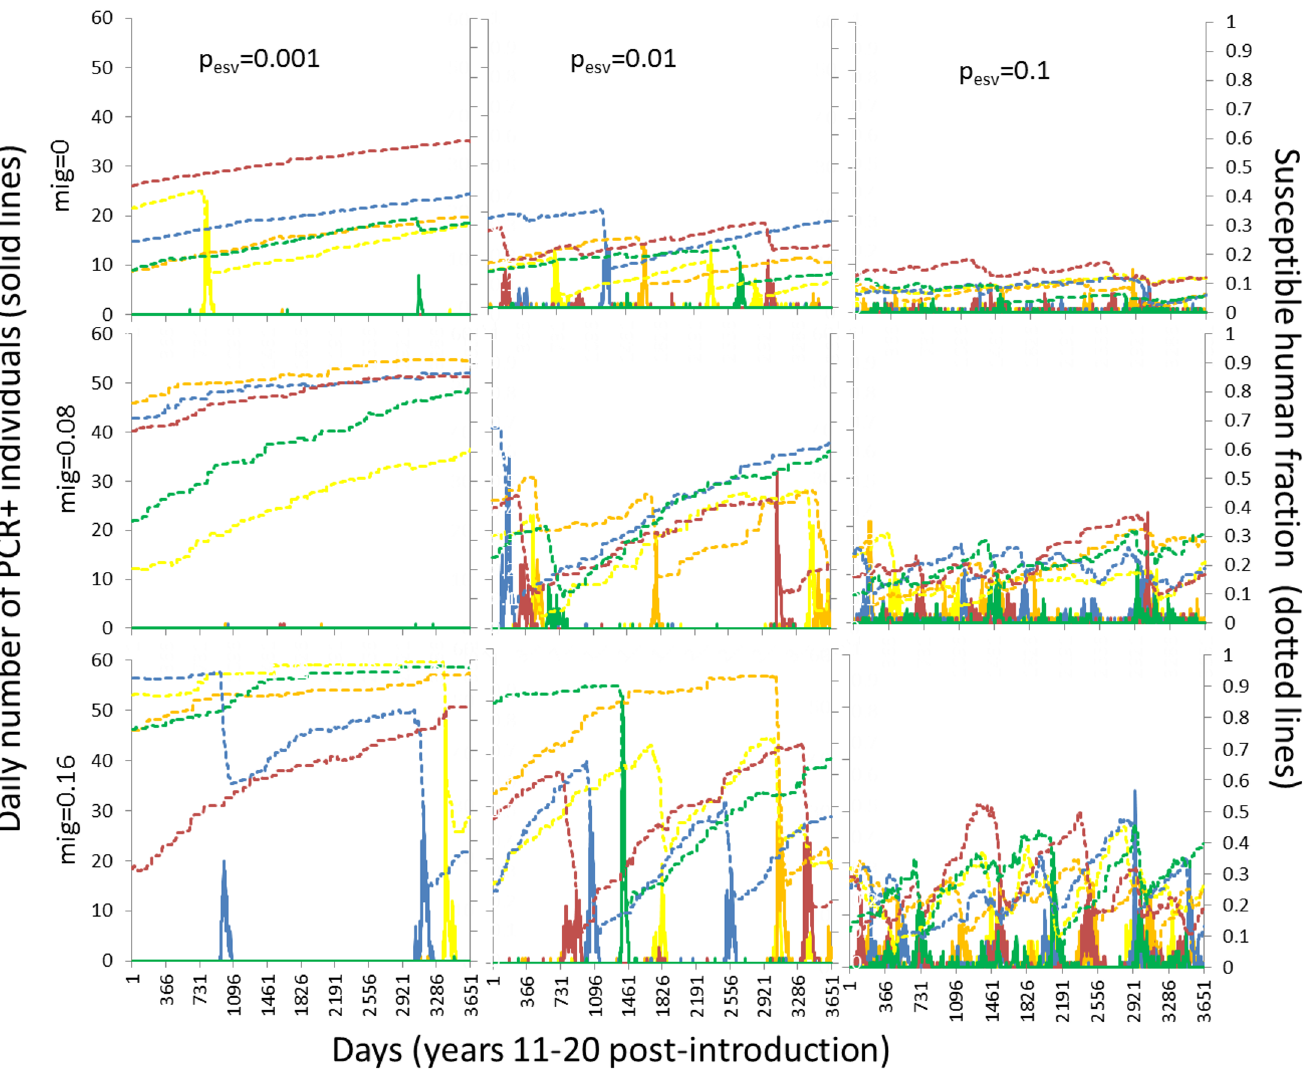
Fig 2. Daily dynamics of transmission 11 – 20 years post invasion for five randomly selected trials for each combination of external social vector exposure ( p esv ) (increasing from left to right) and migration ( mig ) (increasing from top to bottom. Birth rate was held at a constant probability of 0.15 births/household/year and vector production was input using the field patch with the highest average rate of A. aegypti production. Dotted lines track the fraction of the population susceptible to dengue (S) and solid lines track the number of infectious people (I).